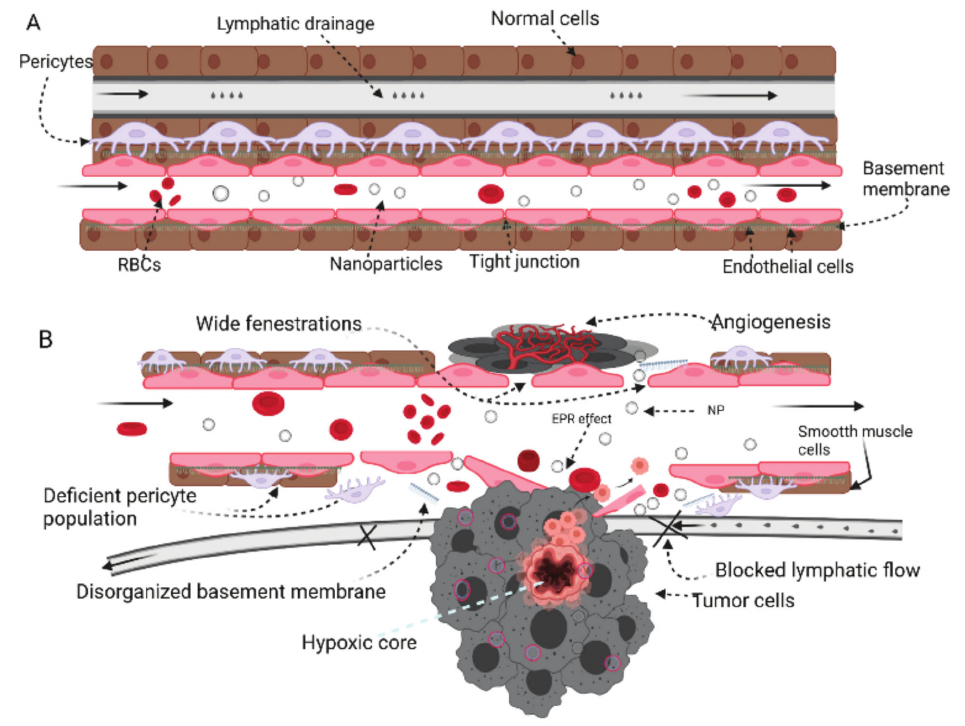
Figure 4. Comparison of properties of cancer cells used in treatment with polymeric nanoparticles with normal tissue structure: ( A ) normal tissue; ( B ) cancer tissue with microenvironment. Reprinted with permission from Ref. [34]. Copyright 2022